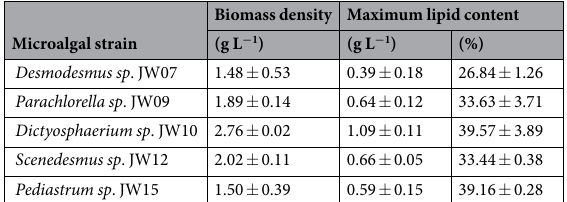
Table 1. Biomass density and lipid content of the isolated microalgal strains.